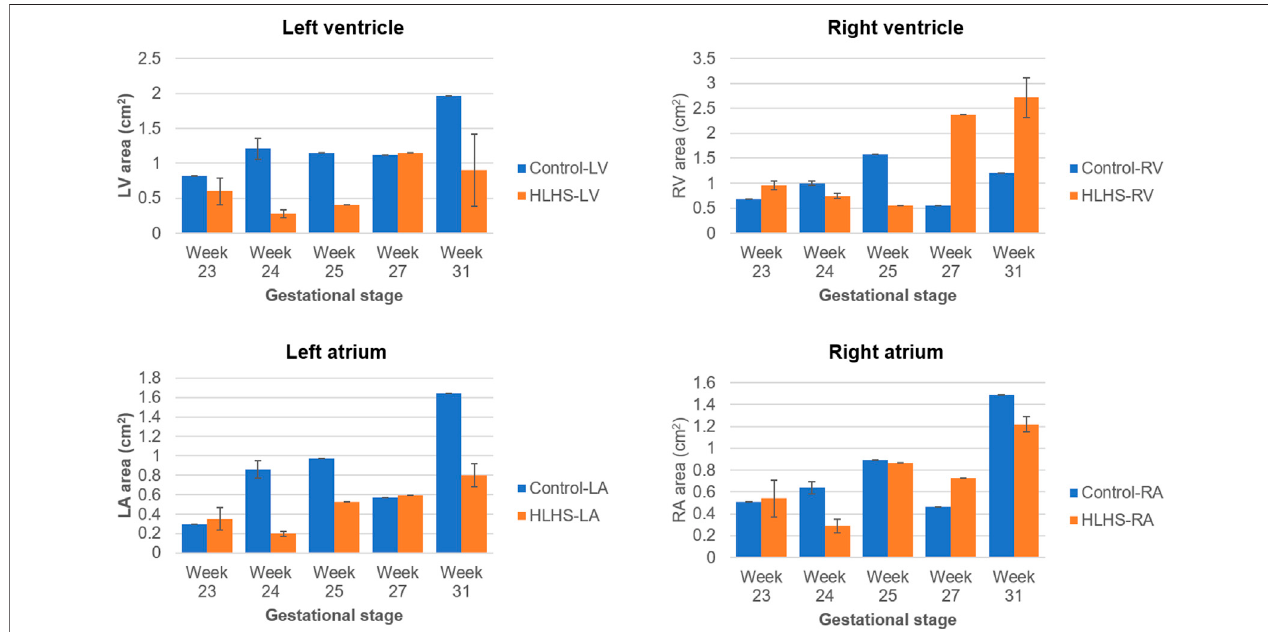
FIGURE 4 | Comparison of cross-sectional areas between the control and HLHS hearts considering various gestational stages.